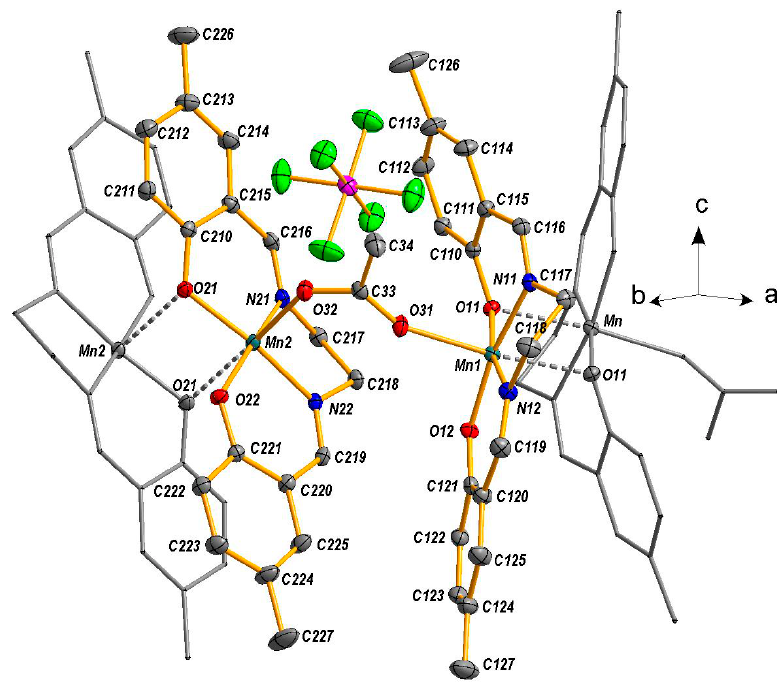
Figure 1. Asymmetric unit with numbering for 2 . The two {Mn(SB)} + units manifold by symmetry are highlighted by grey color. Hydrogen atoms are omitted for clarity. SB: Schiff base.